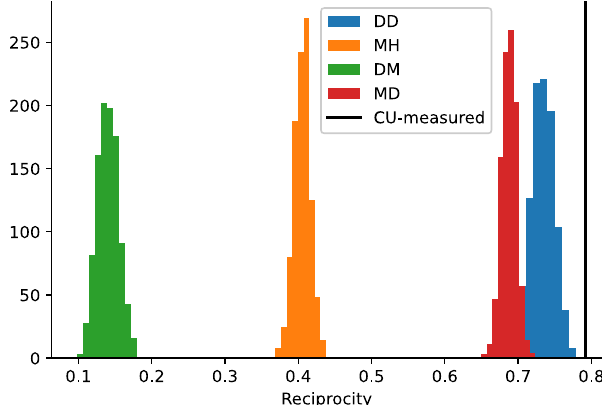
FIG. 8. Distributions of reciprocities for each of the four random network methods developed in this study. For each method, 1000 random networks were created.